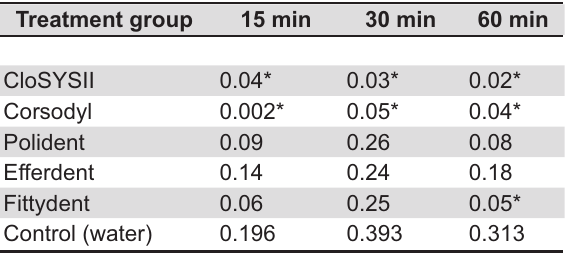
Table 2- P values for the number of colony-forming units of &'!($('",-- over the evaluation periods of 15, 30 and 60